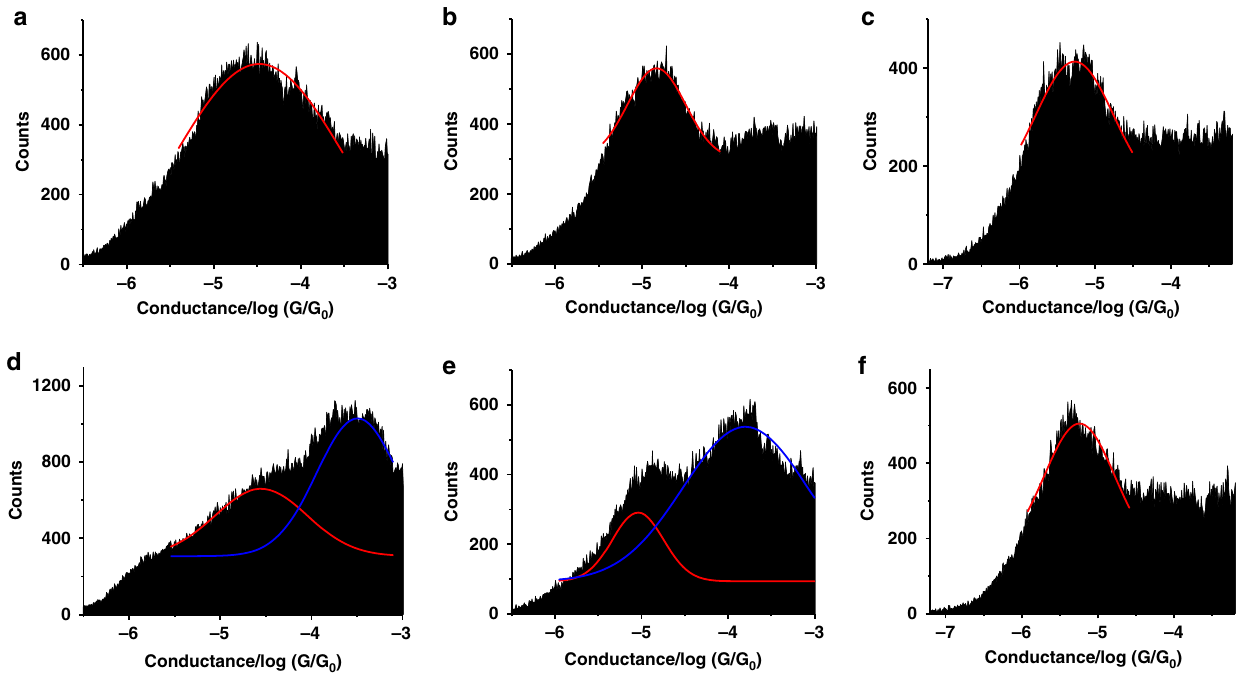
Fig. 3 Conductance histograms of metallocycles and their host – guest complexes with C 60 . Conductance histograms constructed from over 1000 individual traces: a for 5 , b for 6 , c for 7 , d for [ 5 + C 60 ], e for [ 6 + C 60 ], and f for [ 7 + C 60 ]. The red and blue curves are Gaussian fi ts of the conductance peaks